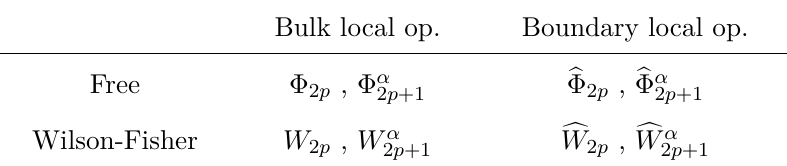
Table 1 . List of symbols for bulk and boundary local operators. The lower indices of the operators denote the canonical dimensions in d = 4